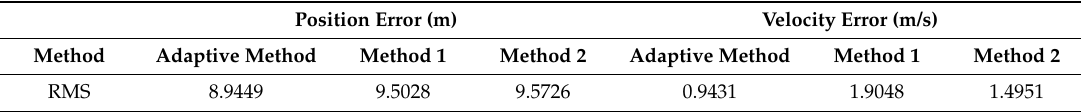
Figure 24. Position ( left ) and velocity ( right ) errors during the simulation in Trajectory 2. Table 3. RMSs of the position and velocity errors in Trajectory 2.